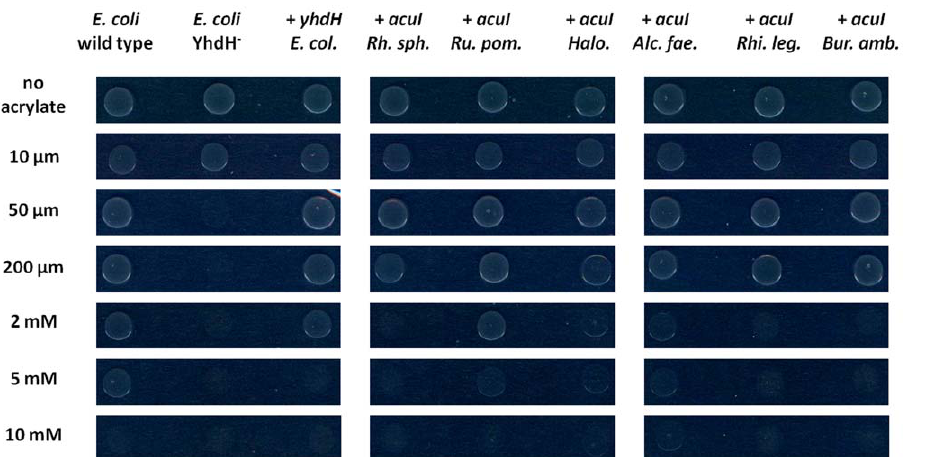
Figure 3. Effects of different acuIgenes on the inhibitory effects of acrylate on the growth of Escherichiacoli . Overnight cultures of wild type E. coli strain BW25113, its YhdH 2 mutant derivative JW3222-1 and derivatives of JW3222-1 containing the cloned yhdH gene of E. coli ( E. col. ) or the acuI genes of Rhodobacter sphaeroides ( Rh. sph. ), Ruegeria pomeroyi DSS-3 ( Ru. pom. ), Halomonas HTNK1 ( Halo ), Alcaligenes faecalis M3A ( Alc. fae. ), Rhizobium leguminosarum 3841 ( Rhi. leg. ) or Burkholderia ambifaria AMMD ( Bur. amb. ) were spotted (10 m l) onto M9 minimal medium agar, with glycerol as the carbon source, plus acrylate at concentrations shown. Plates were incubated at 37 u C for 20 hours.